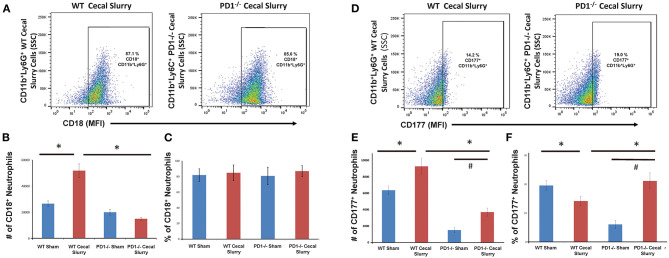
Flow cytometry with CD18+ neutrophils being gated as CD11b and Ly6G-positive among lung samples (A) for wildtype (WT)-cecal slurry (CS) group vs. PD1−/− CS mouse (paired representative dot-plots). The absolute number of CD18+ cells (B) was significantly higher among WT-CS mouse lungs compared to the other groups. However, on analysis of the percentage of CD18-positive cells (C), there was no difference among the groups. Flow cytometry with CD177+ neutrophils being gated as CD11b and Ly6G-positive among lung samples (D) for wildtype (WT)-cecal slurry (CS) group vs. PD1−/− CS mouse (paired representative dot-plots). The absolute number of CD177+ cells (E) was highest among WT-CS mouse lungs, but this rise was mitigated in the PD1−/− CS group. Analysis of the percentage of CD177+ cells (F), showed differences between WT Sh and WT CS as well as PD1−/− Sh and PD1−/− CS groups. Mean ± SEM, n = 5–8 per group; *P < 0.05 vs. WT CS group; #P < 0.05 vs. PD1−/− CS group; ANOVA with Holm-Sidak post-hoc analysis.